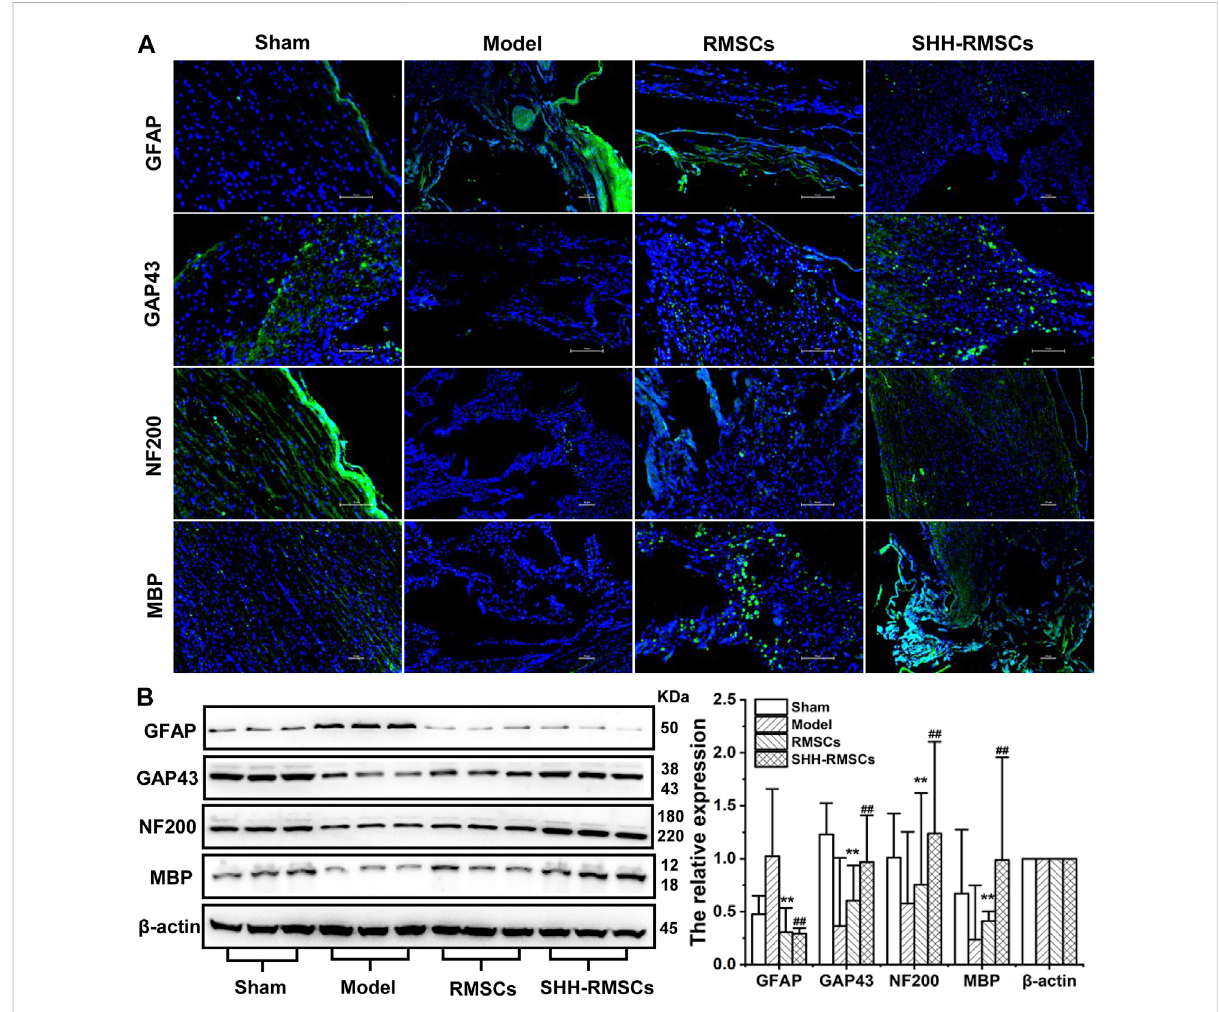
FIGURE 7 (A) The immuno fl uorescence of Sham, Model, RMSCs and SHH-RMSCs, including GAP43, NF200, MBP, and GFAP. SHH-RMSCs could signi fi cantly improve the expression of NF200, MBP, and GAP43, but inhibit the expression of GFAP. (B) The protein expression of GAP43, NF200, MBP, and GFAP in the Sham, Model, RMSCs, and SHH-RMSC groups. (**, ## , p < 0.01, compared with model).